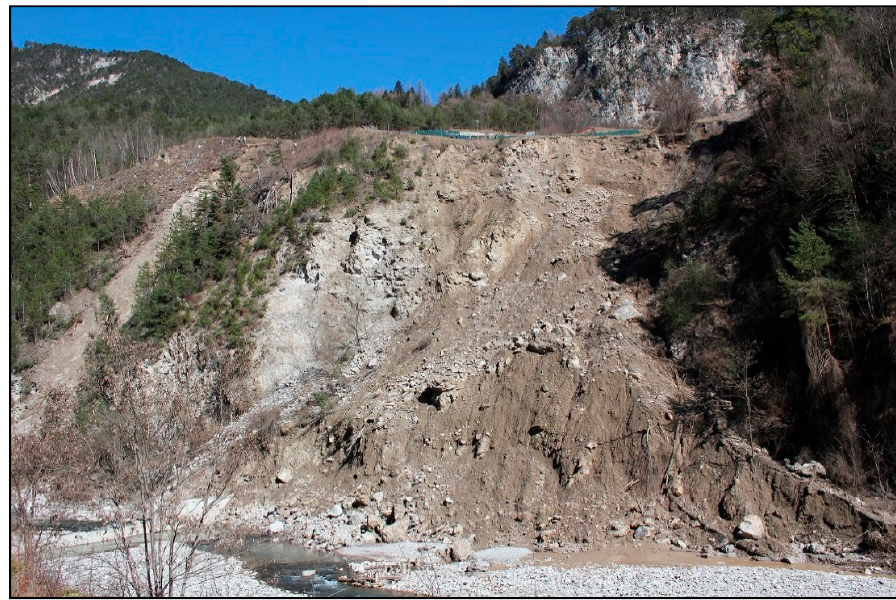
Figure 10. Frontal view of the landslide showing the complex composition of the soil involved.